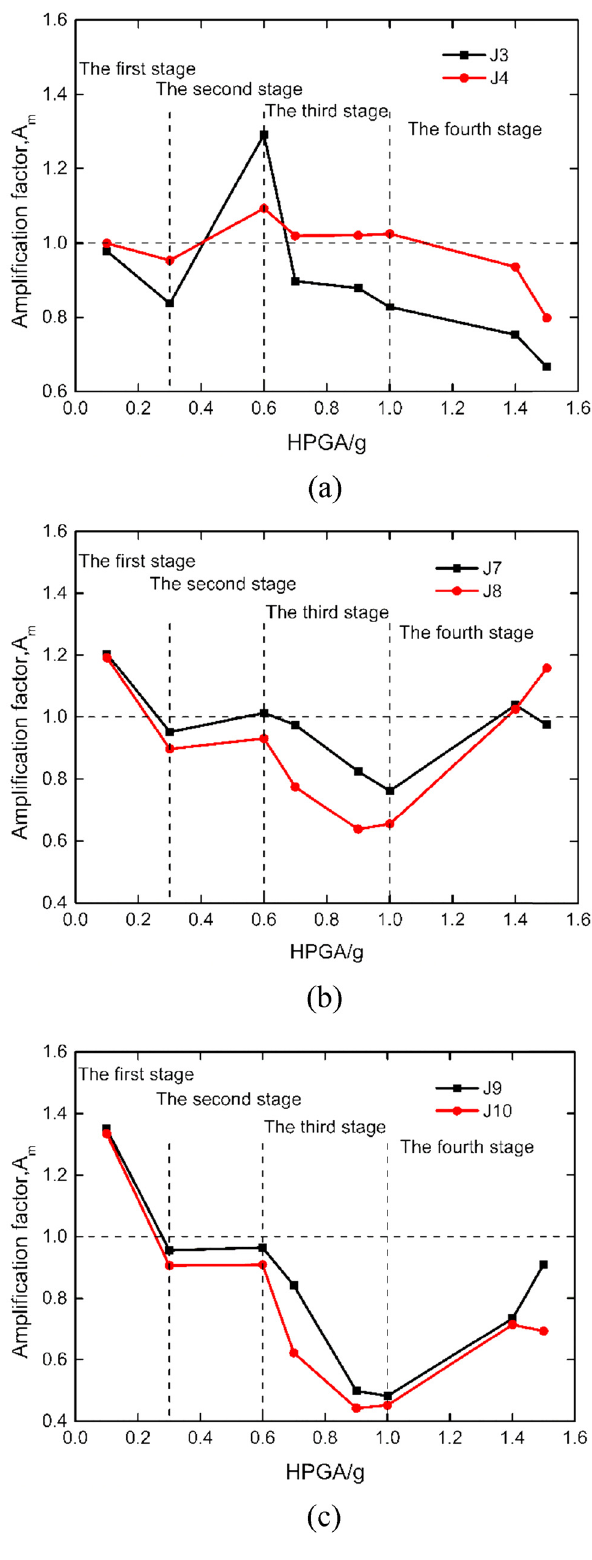
Figure 12: Ampli fi cation factor A m at similar elevations against variable HPGA: ( a ) elevation of 25 cm; ( b ) elevation of 55 cm; and ( c ) elevation of 70